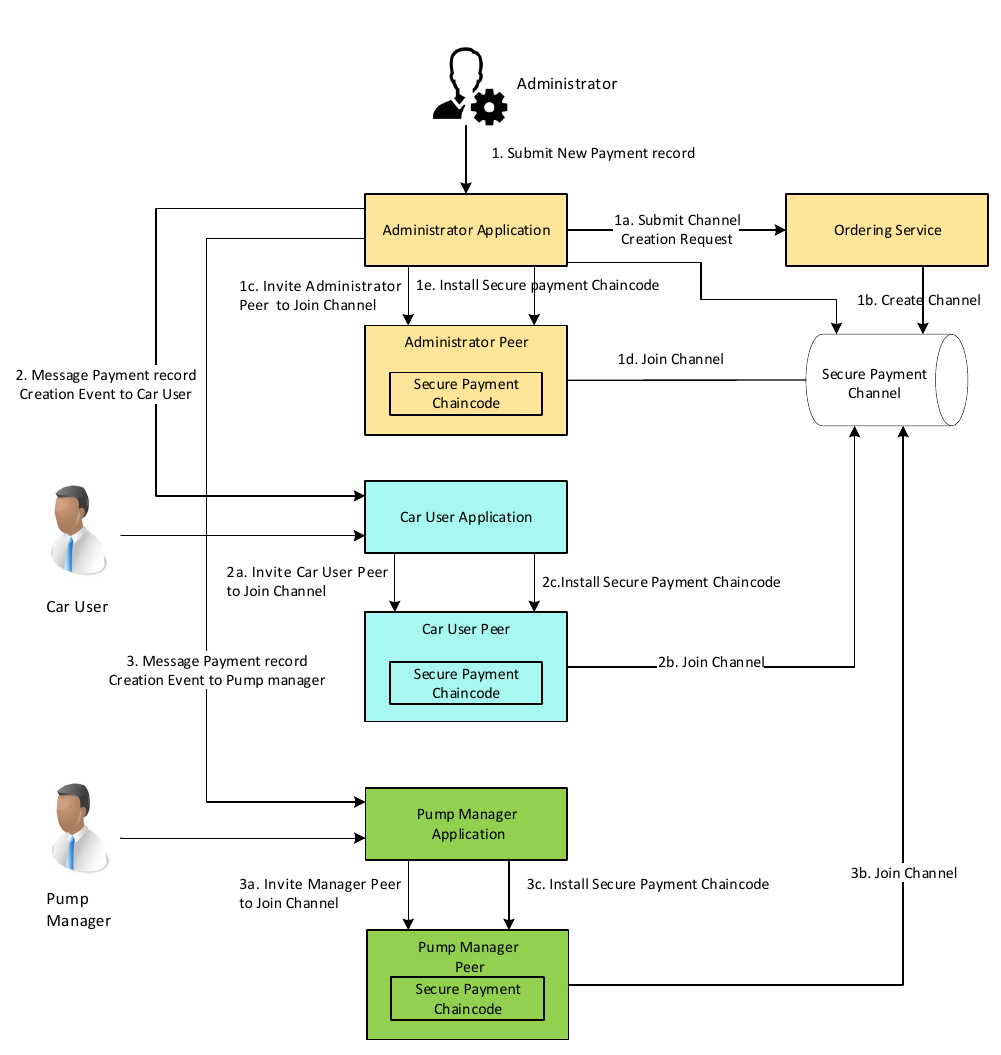
Figure 8. Workflow for channel creation and setting chaincode in proposed blockchain